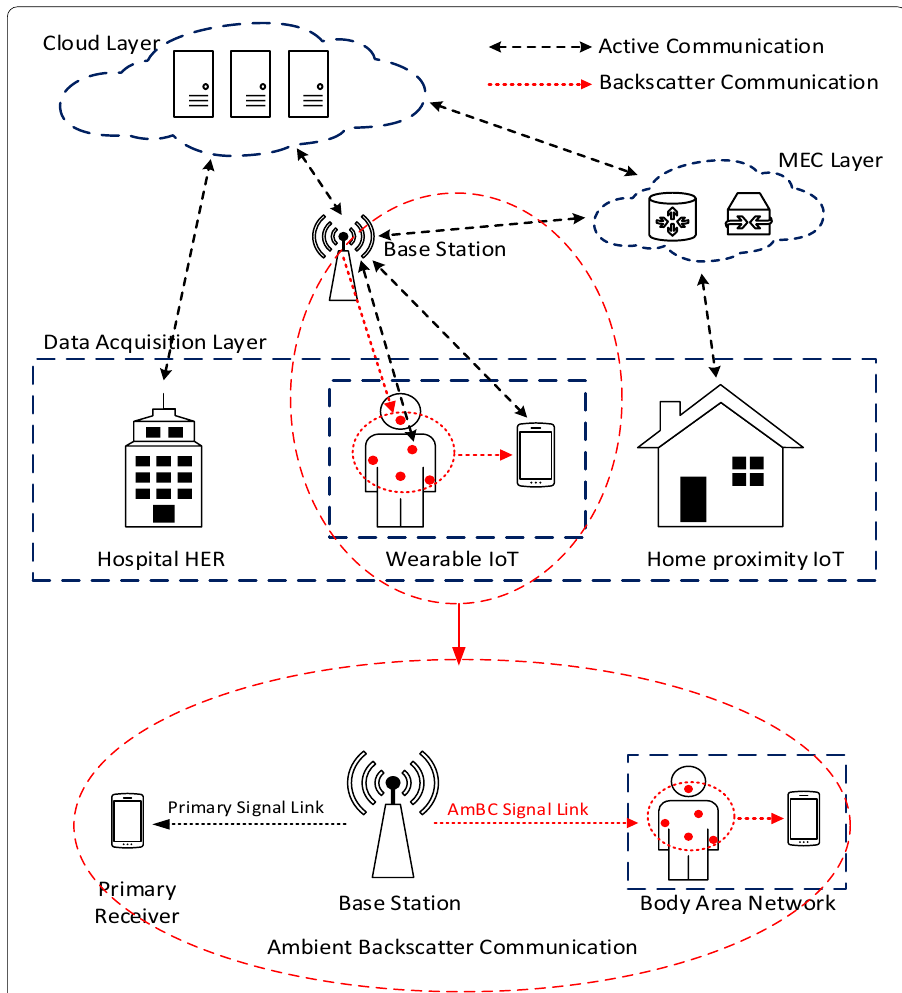
Fig.1 Ambient backscatter communication-based smart 5G IoT